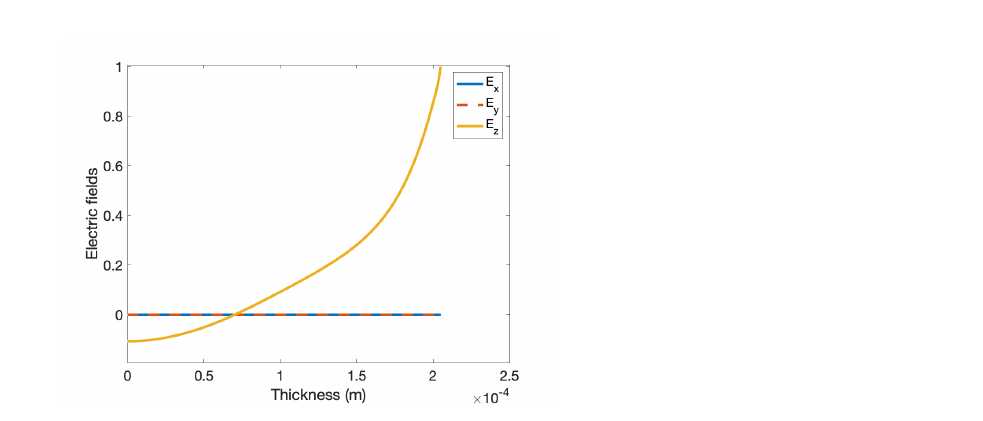
Figure 9. Through-the-thickness-simulated electric field when the incident field is polarized in the direction of the fibers for ω 2 = 24.5 GHz.